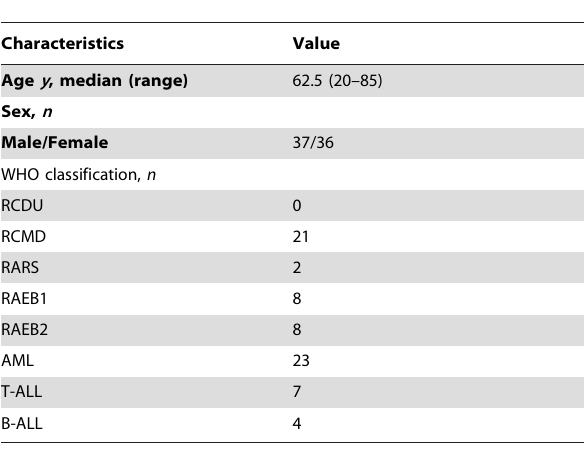
Table 1. Clinical characteristics of patients.